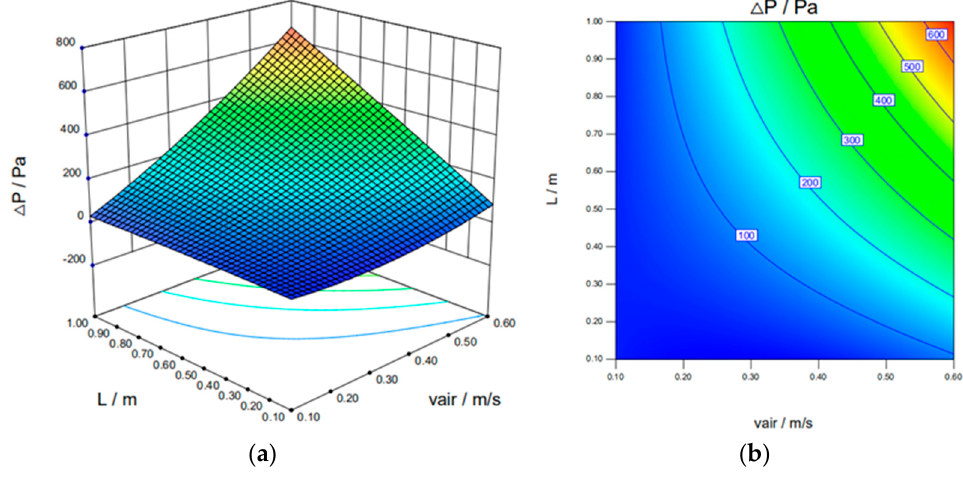
∆ p ( a ) and the contour plots ( b air and L on the